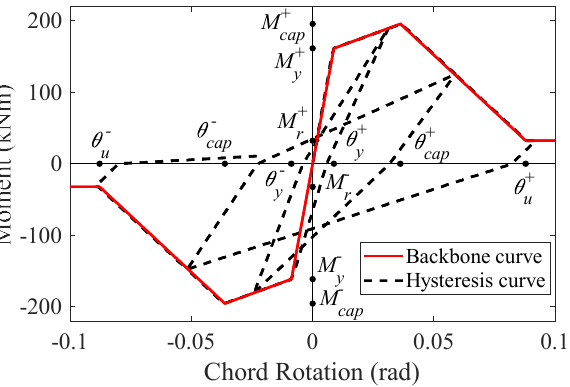
Figure 5. Expected behaviour of columns by coupling the flexural spring with the shear spring.